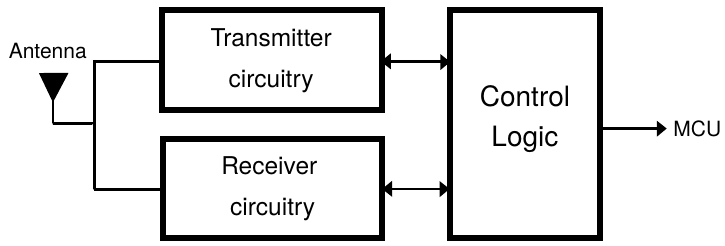
Figure 1. Communication module: simplified